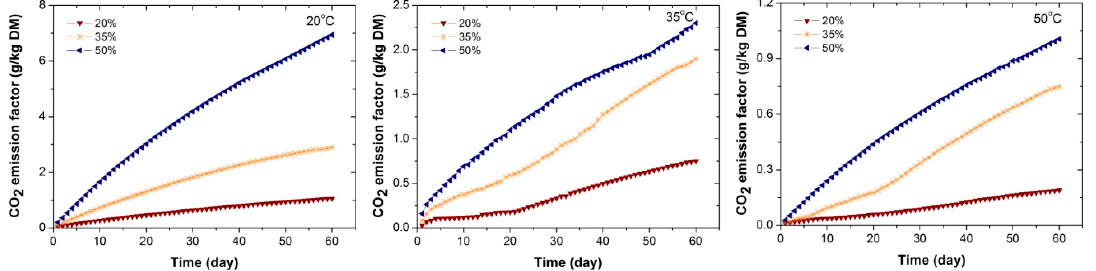
Figure 6. Emissions of CO 2 from stored WRC chips with different initial moisture contents at 20 °C, 35 °C and 50 °C under aerobic condition.